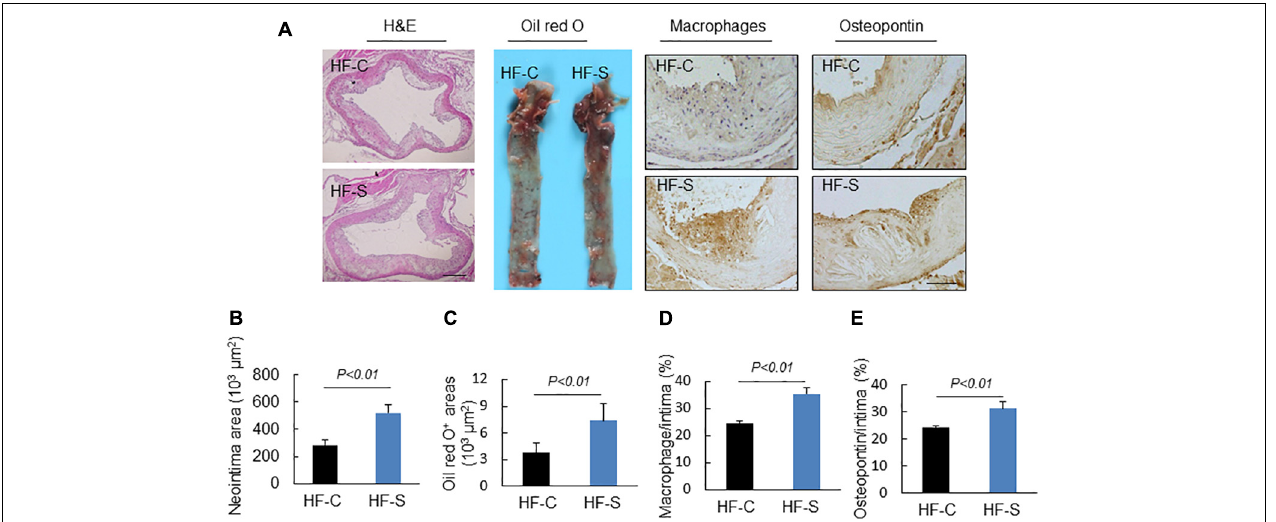
FIGURE 2 | Histological characterization of atherogenic plaques in aortic roots of two experimental groups (high-fat diet alone, HF-C; high-fat diet plus stress, HF-S). (A) Representative images applied to evaluate the neointimal hyperplasia, content of lipid-rich plaques, macrophages accumulation and osteopontin expression. (B–E) The areas for H&E, Oil red O + and positive areas in the neointimas for osteopontin and CD68 were quantified for each section. Results are presented as neointima area, the ratio of Oil red O-stained area to the total aortic root, the ratio of the positively stained area (CD68, osteopontin) to the neointimal area in the atherosclerotic lesions. Values are presented as means ± SEM ( n = 6–7). p < 0.01 vs. HF-C by Student’s t -test. Scale bars: 50 µ m.